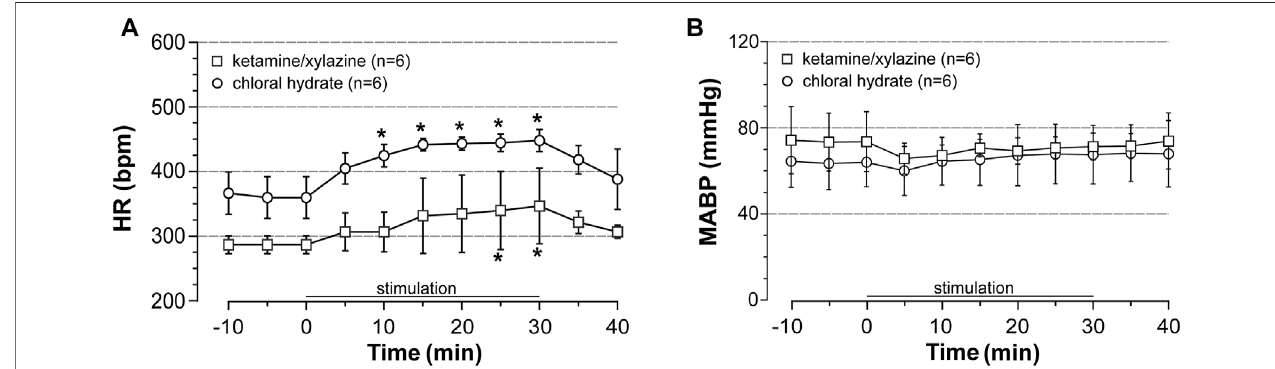
FIGURE 1 | Effectsof induced contraction on heart rate (HR) and blood pressure (BP). HR and mean arterial blood pressure (MABP) were recorded before, during (0 – 30 min) and after electrically induced contraction of hindlimbs (5x MT) in rats anesthetized either with ketamine/xylazine or chloral hydrate. Values are expressed as means±SD, n =numberofrats.*differentfrompre-stimulationvaluesat p < 0.01andnodifferencebetweenanestheticagentsaftertwo-way(timexgroup)ANOVAand Bonferroni correction.